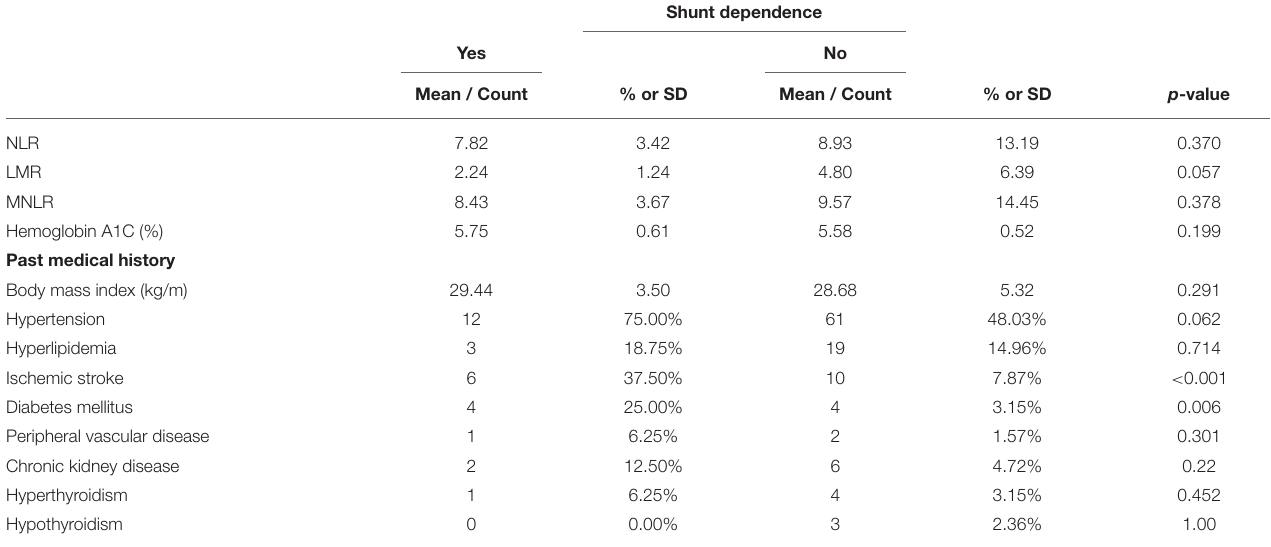
TABLE 2 | Multivariate logistic regression analysis with adjusted odds ratios of shunt dependence after aneurysmal subarachnoid hemorrhage. Variable